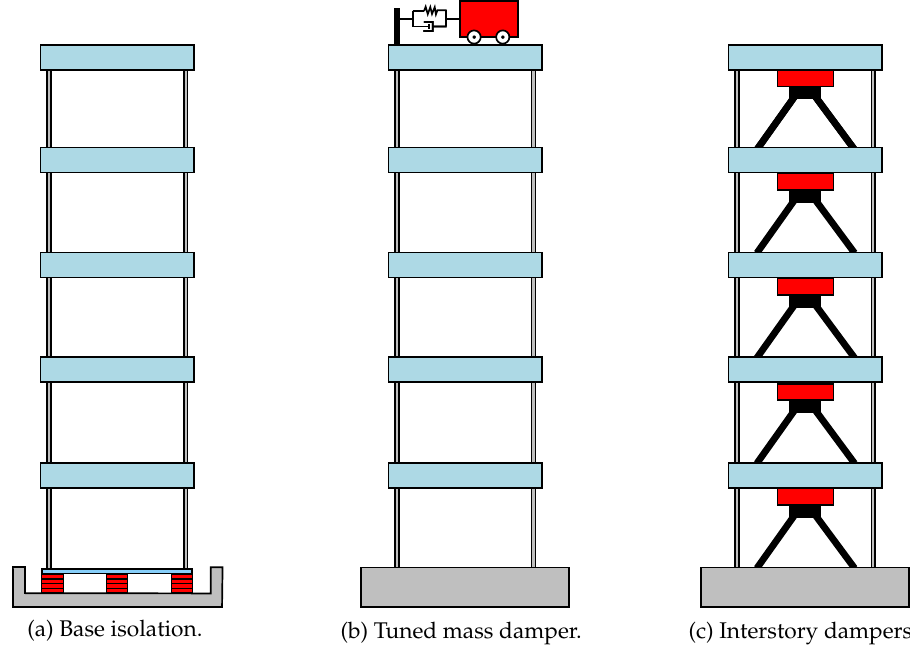
Figure 1. Passive vibration control strategies for seismic protection of multistory